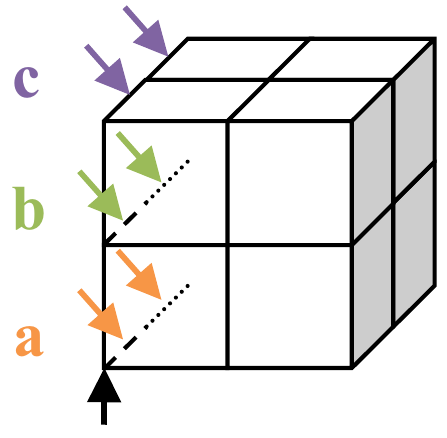
Fig. 14 Illustration of the Joint-Y joints when x =